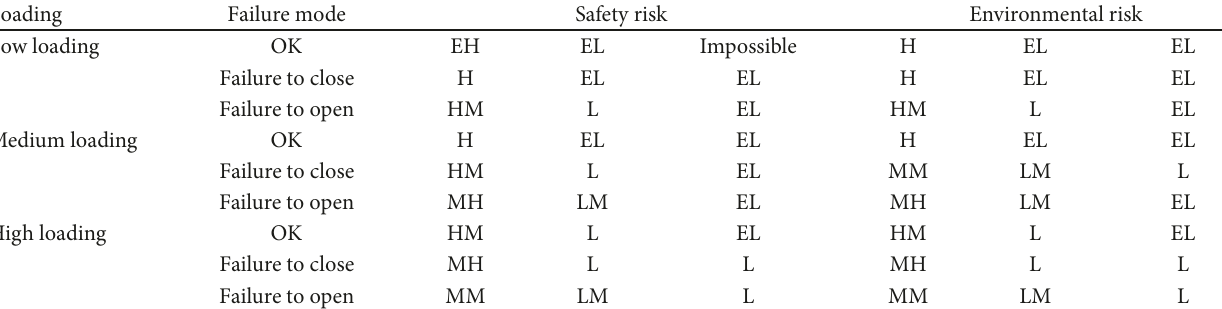
Table 7: Conditional probabilities of consequences.